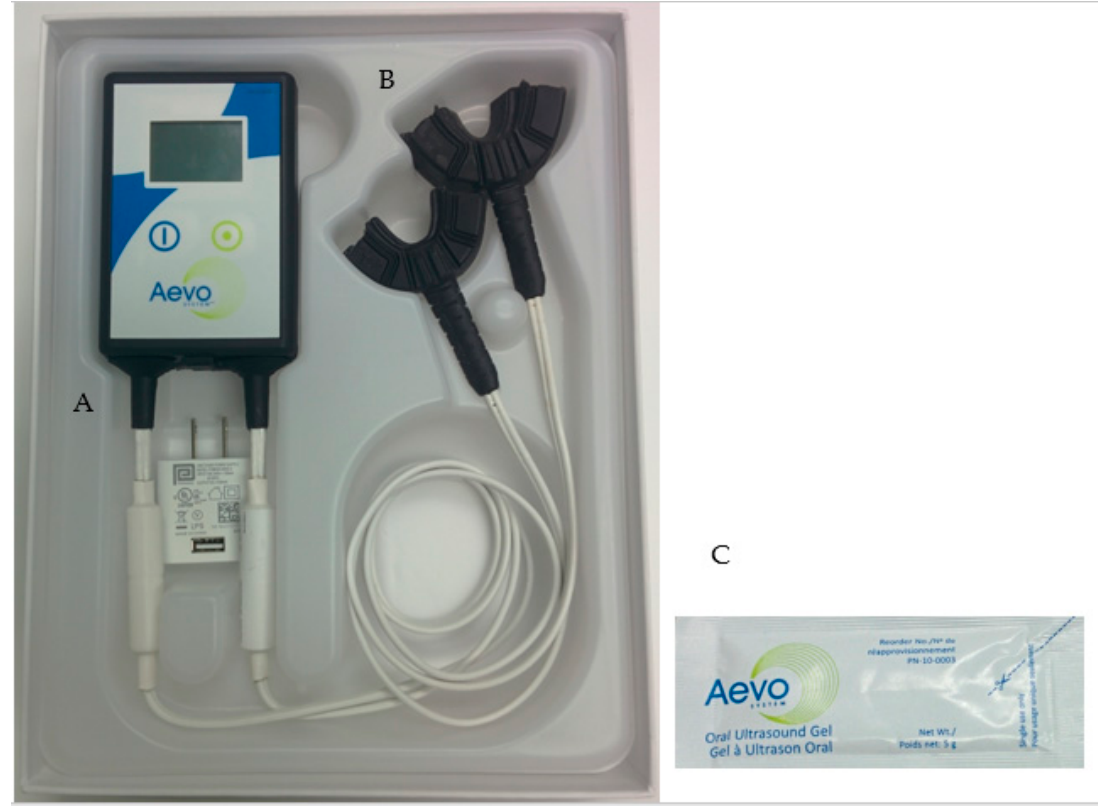
Figure 1. Low-intensity pulsed ultrasound (LIPUS) device (Aevo System). ( A ): Handheld electronics; ( B ): mouthpieces; and ( C ): ultrasound coupling